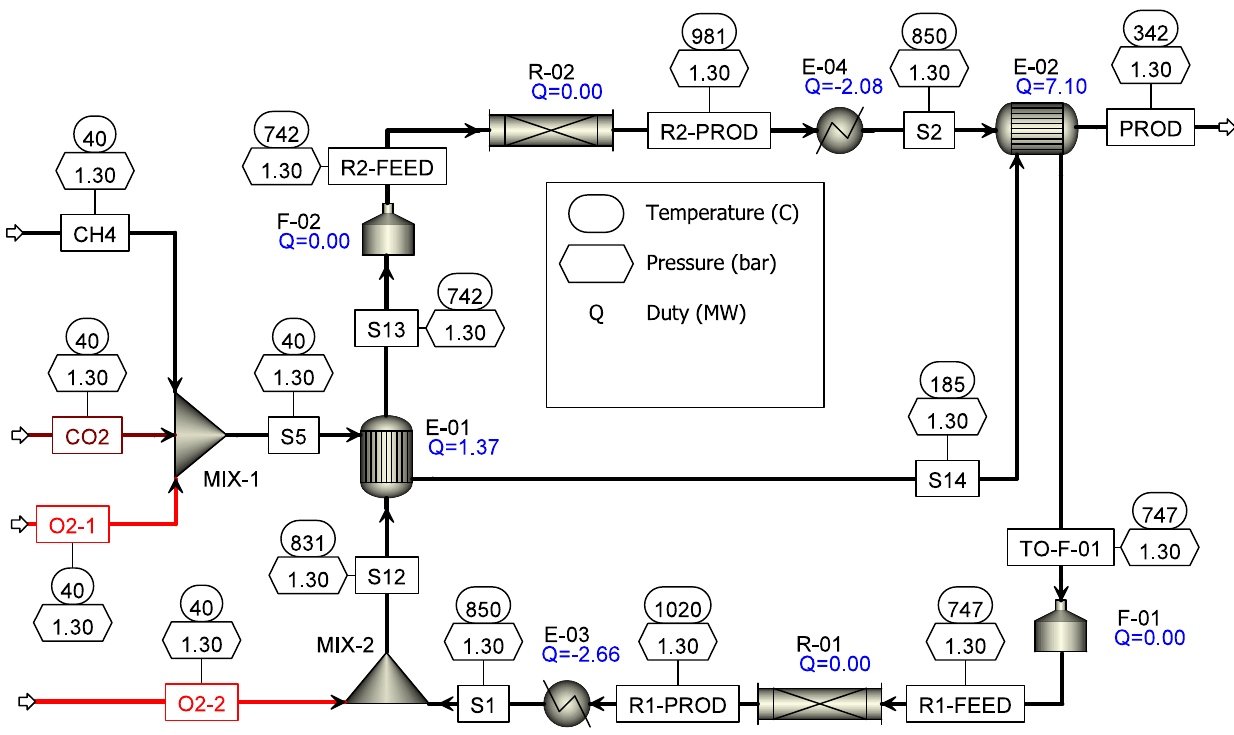
Figure 4. Process simulation with optimal operating conditions for the reaction section of the Bio-OCM plant carried out in Aspen Plus software. Black lines (process streams) and red lines (oxygen streams). Reproduced with permission from Penteado, Ph.D. Thesis, TUB, 2021